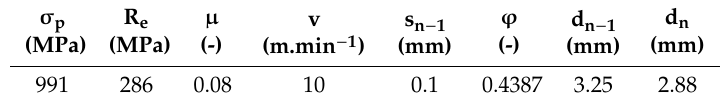
Table 2. The boundary conditions for the simulation of drawing with a floating mandrel.